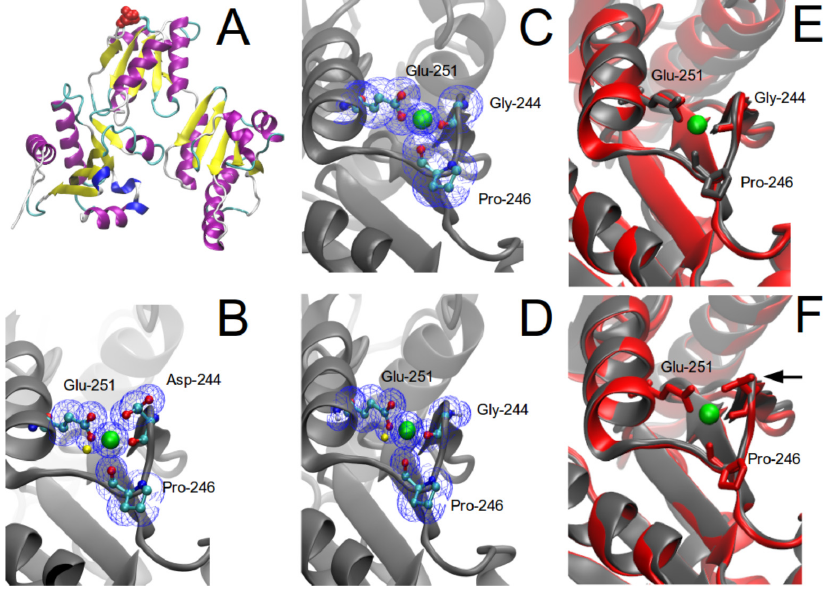
Fig 3. Molecular modeling of CASQ1. ( A ) Ribbon representation of a CASQ1 monomer ( the red spheres indicate the D244 residue ). ( B ) Close up view of the region of interest in WT protein. A Ca 2+ ion ( green sphere ) is coordinated by the carbonyl oxygen of the backbone and the carboxylic acid group of the side chain of aspartate 244 ( oxygen atoms and water molecule are shown as red and yellow spheres , respectively ). Two other residues (glutamate E251 and proline 246) also coordinate the same Ca 2+ . ( C ) Homology modelling of CASQ1 in which the aspartate 244 was replaced by a glycine ( see Methods ). ( D ) Crystal structure of CASQ1 carrying the D244G mutation determined by X-Ray diffraction ( see text ) [13]. ( E ) Superimposition of the homology model ( grey ) and the crystal structure ( red ) for CASQ1-D244G protein. ( F ) Superimposition of the homology model ( grey ) and the crystal struxcture ( red ) for CASQ1-WT protein ( the arrow indicates the residue D244